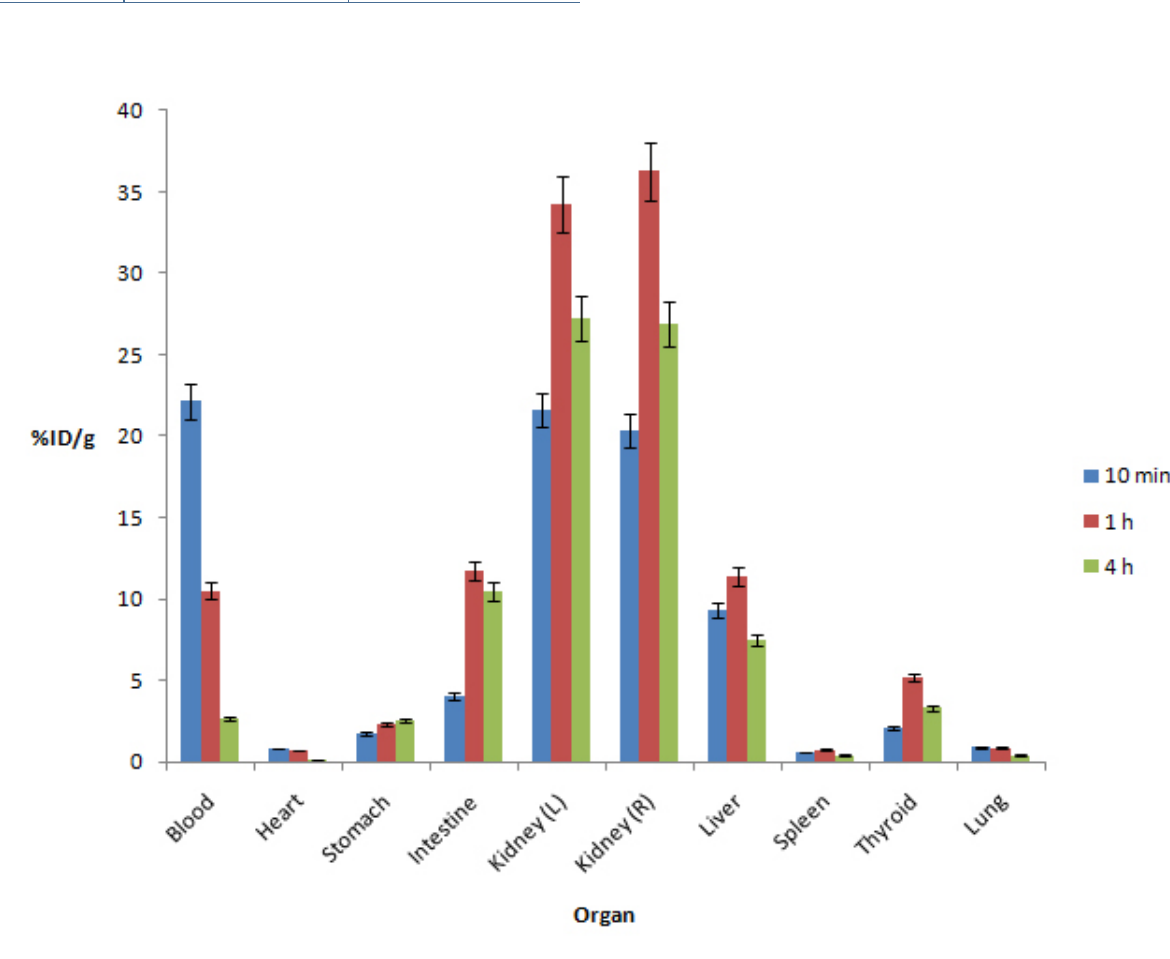
Figure 4. Fractions of F3.1 obtained by cation- exchange chromatography with CM resin.